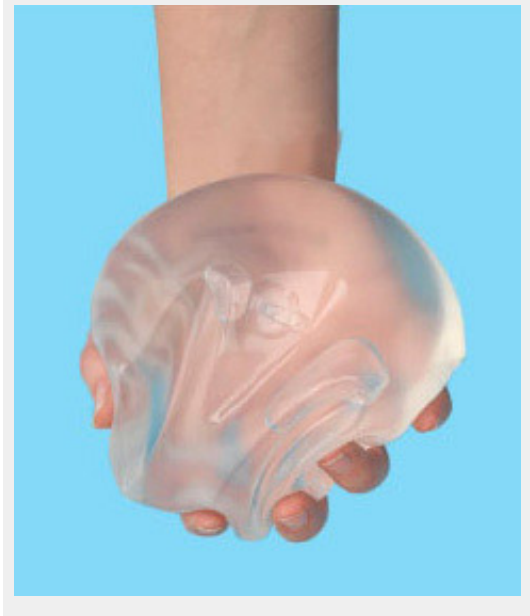
Silicone rubber breast implant shell, to be filled with saline during surgery. In-situ filling allows for custom volume adjustment. If later (e.g., years) after implantation the saline-filled shell ruptures, the saline disperses rapidly and harmlessly, but makes a highly obvious change in the recipient’s appearance. © Natrelle. Reprinted with